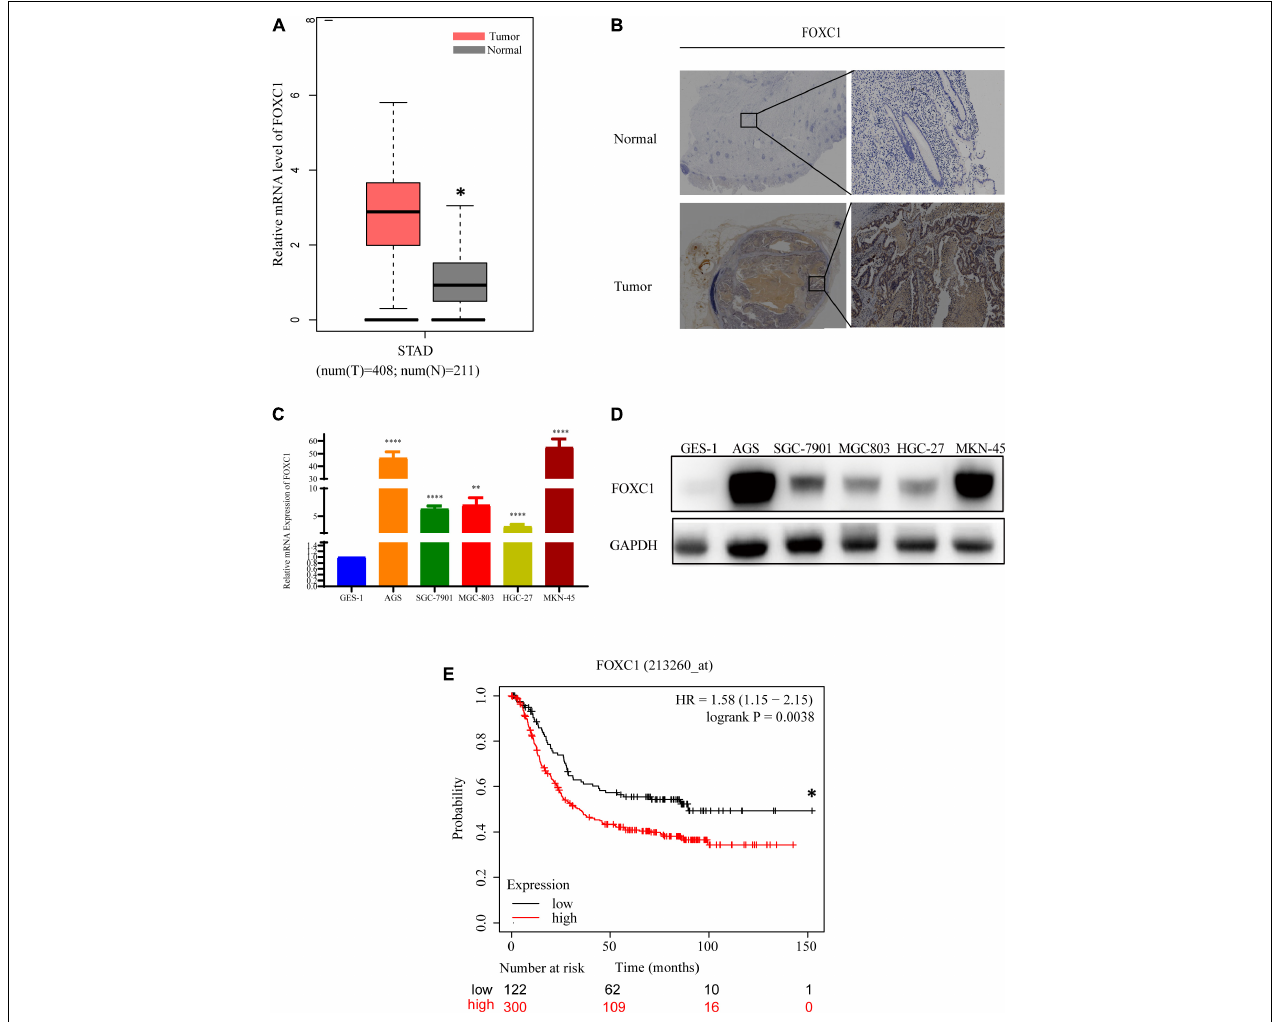
FIGURE 1 | FOXC1 expression is upregulated in human gastric cancer tissues and cell lines. (A) Comparison of relative mRNA levels of FOXC1 in gastric cancer and normal tissues. The data were downloaded from GEPIA (http://gepia.cancer-pku.cn/detail.php?gene = FOXC1). (B) IHC staining was applied to detect FOXC1 protein levels in gastric cancer and normal tissue. FOXC1 expression level was higher in 85.7% (18/21) of the GC tissues and representative images show increased FOXC1 expression in GC tissue (below panel) compared with adjacent normal gastric tissues (upper panel). (C,D) mRNA and protein levels of FOXC1 in the gastric cancer cell lines AGS, SGC-7901, MGC-803, MKN-45, HGC-27, and the GES-1 cell line. The expression levels of FOXC1 were normalized to GAPDH. ( ∗ P < 0.05, ∗∗ P < 0.01, ∗∗∗∗ P < 0.001). (E) Kaplan-Meier curves for the survival time of patients with gastric cancer. The data was obtained from Kaplan-Meier Plotter and affy ID of FOXC1(213260_at) dataset used for the analysis (http://kmplot.com/analysis/index.php?p = service). High and low expression groups are 300 and 122, respectively. The median survival time for high and low expression groups are 89.43 and 34.3 months respectively ( p = 0.0038). Log-rank tests were used to determine statistical significance (* P <